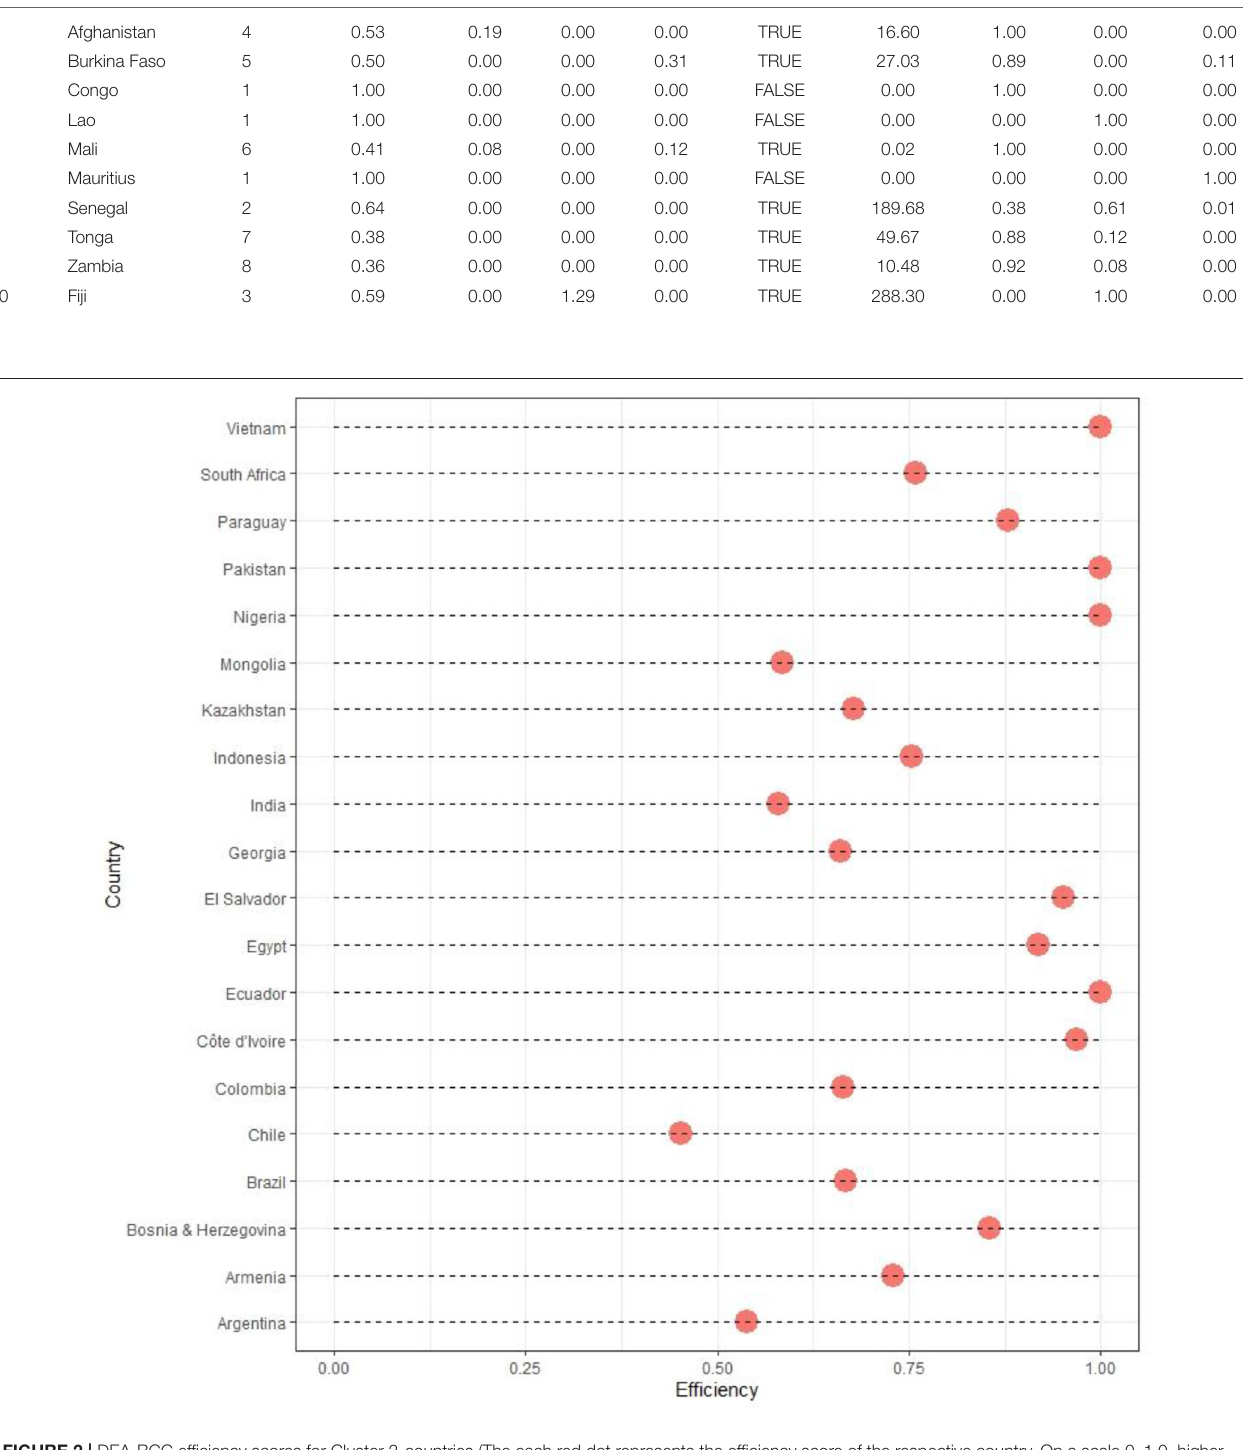
Frontiers in Climate |